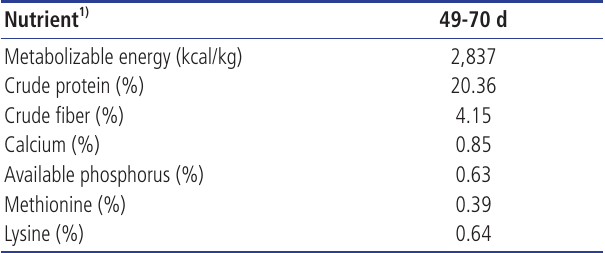
Table 1. Analyzed nutritional components of the experimental meat-type